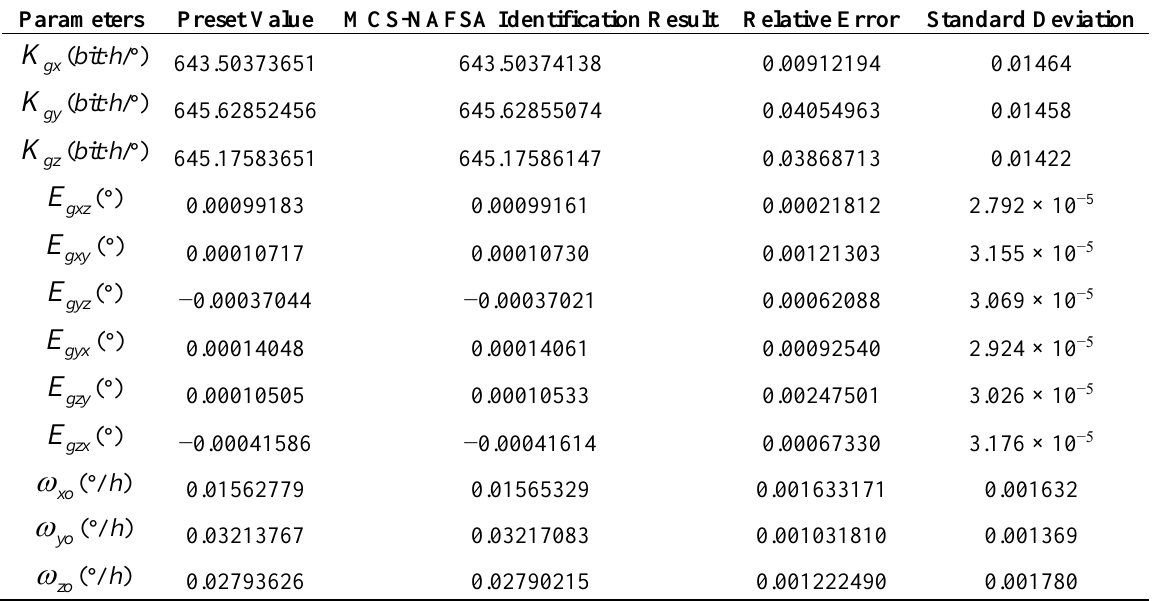
Table 3. FOG error parameters MCS-NAFSA identification